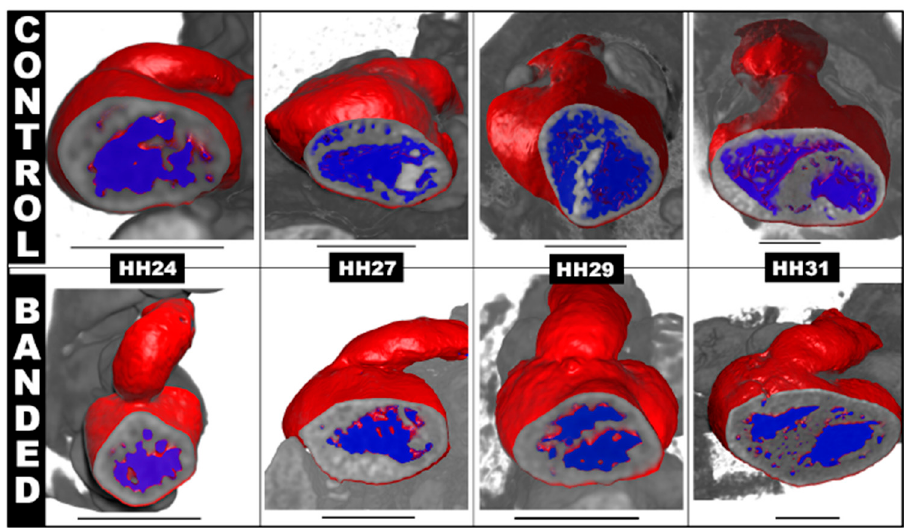
Figure 11. Ventricular growth and septation during embryonic heart development via 3D recon- struction of microCT scan data. The images focus on the septation of left and right ventricles in the embryonic chicken heart at different stages of development. At HH24 (after 24 h of OTB or banding intervention), the suture is removed. The primitive ventricle is not yet septated. At later stages, the banded hearts form a larger left ventricle and smaller right ventricle, compared to control hearts. At HH31, the banded heart here shows a clear septum between right and left ventricles accompanied by increased trabeculation. Scale bar is 1 mm for all images.